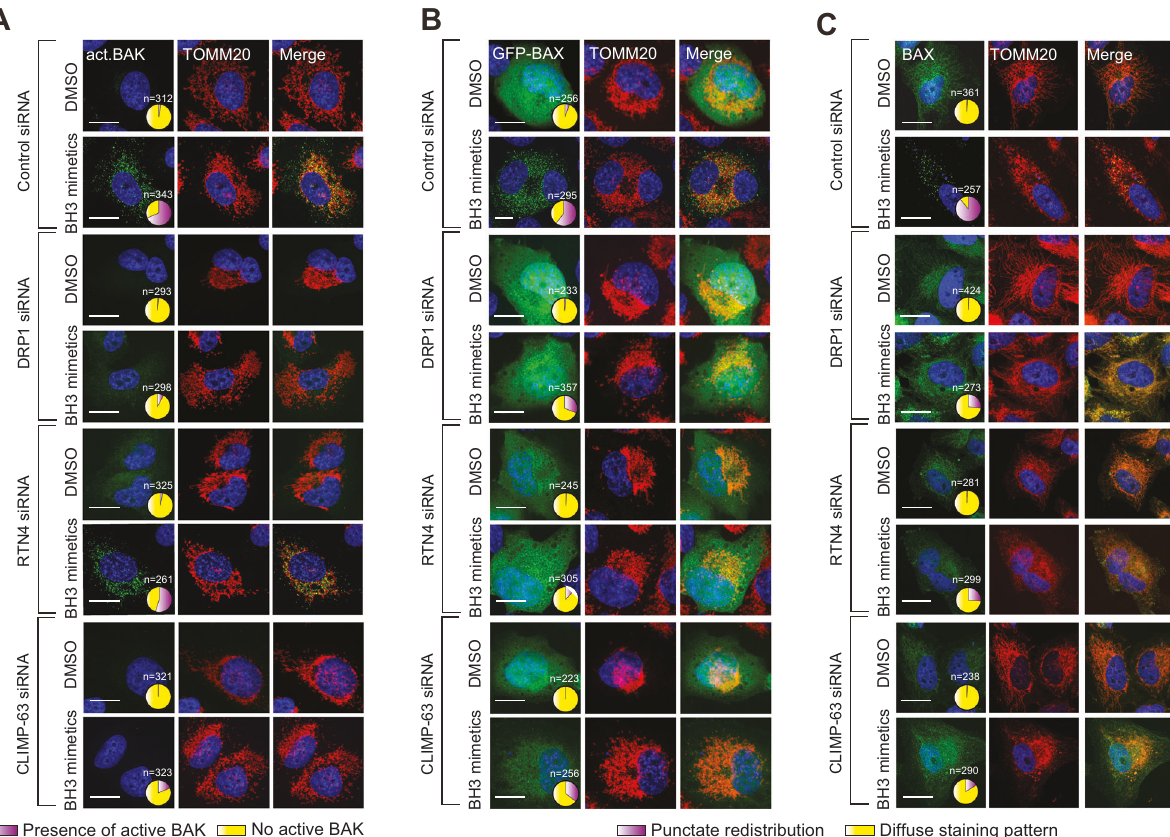
Fig. 7 DRP1 and CLIMP-63 mediate BAK activation, and along with RTN4, regulate BAX translocation. A H1299 cells were transfected with control, DRP1, RTN4 or CLIMP-63 siRNA for 72 h, exposed to Z-VAD.fmk (30 μ M) for 0.5 h, followed by a combination of BH3 mimetics, A-1331852 (0.1 μ M) and A-1210477 (10 μ M), for 4 h. Cells were then fi xed and immunostained against active-BAK (green) and TOMM20 (red) and the appearance of active BAK on the mitochondrial membrane (punctate staining pattern) quanti fi ed in the indicated numbers of cells ( n ) across 3 independent experiments; the results are displayed as pie charts here, and as bar graphs in Supplementary Fig. 13. B H1299 cells, overexpressing GFP-BAX, transfected and treated as in ( A) , were fi xed and immunostained against TOMM20 (red) and the extent of BAX (green) redistribution to the mitochondrial membrane (punctate staining pattern) was quanti fi ed and plotted as above. C HeLa cells, transfected and treated as in ( A ), were fi xed and immunostained against BAX (green) and TOMM20 (red) and the extent of BAX redistribution (green, punctate) quanti fi ed and plotted as above. Scale bars are 10 μ